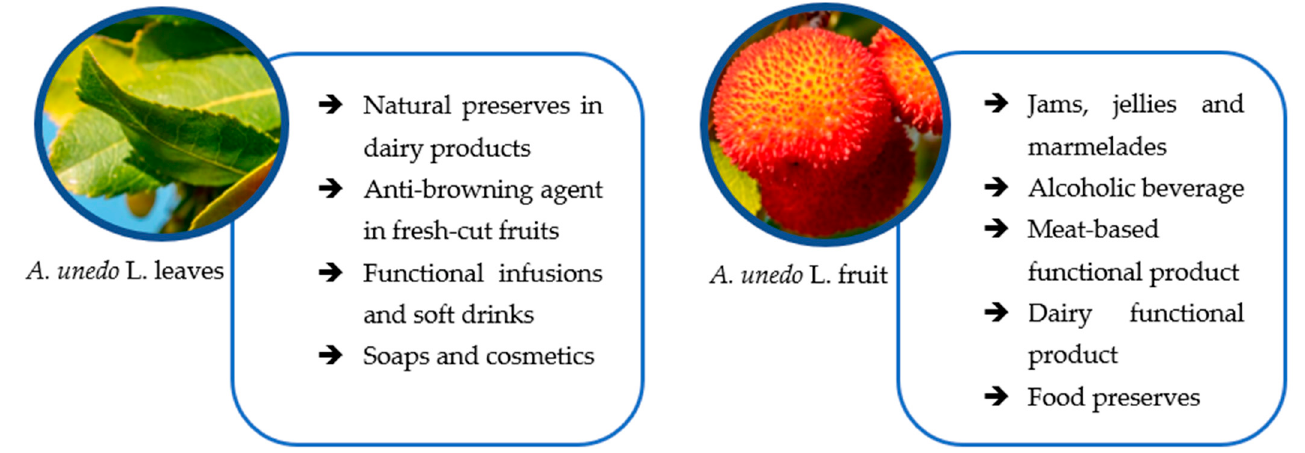
Figure 5. Economi c perspective of A. unedo L. fruit and leaf utilization [138]. Figure 5. Economic perspective of A. unedo L. fruit and leaf utilization